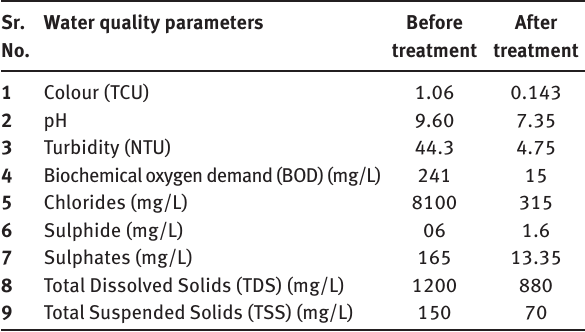
Table 2: Physico-chemical assessment of waste water before and after treatment with Ag